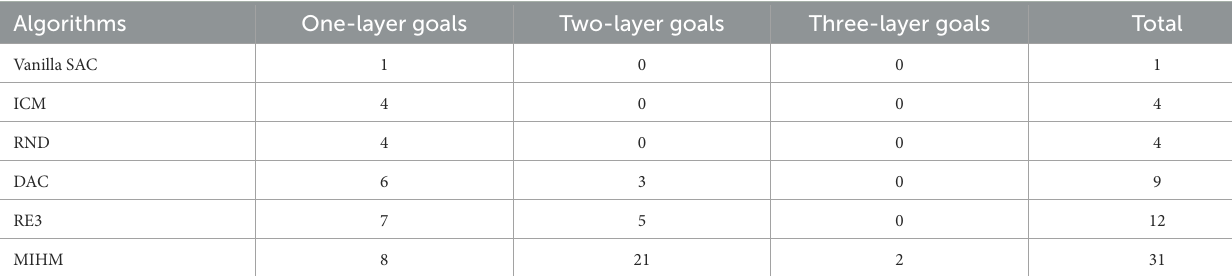
TABLE 2 The number of finally learned goals (whose success rates are > 80%) in each goal category for four algorithms.